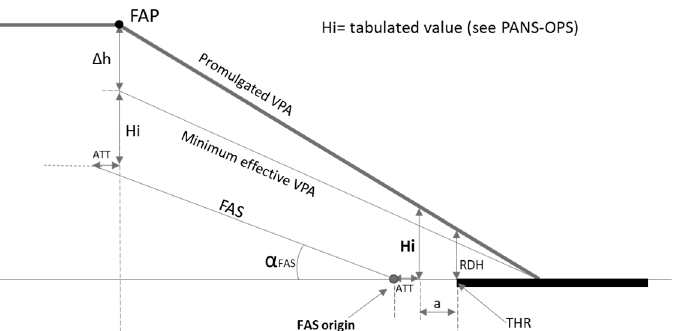
Figure 2. E ff ective VPA vs. fi nal approach surface (FAS). Where: ATT: along track tolerance; α FAS : fi nal approach surface slope; Hi: tabulated value depending on the airport elevation.